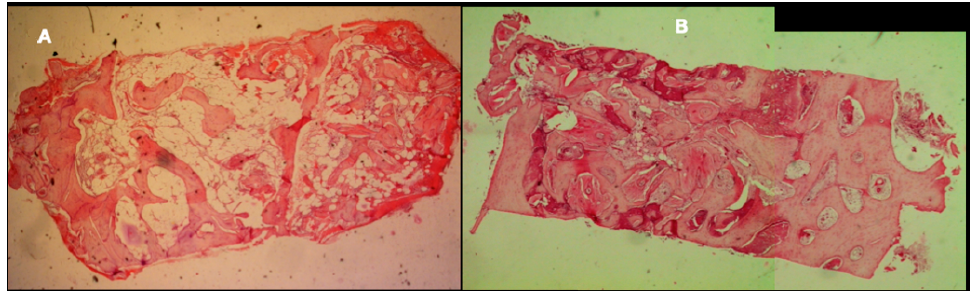
hard tissue areas.